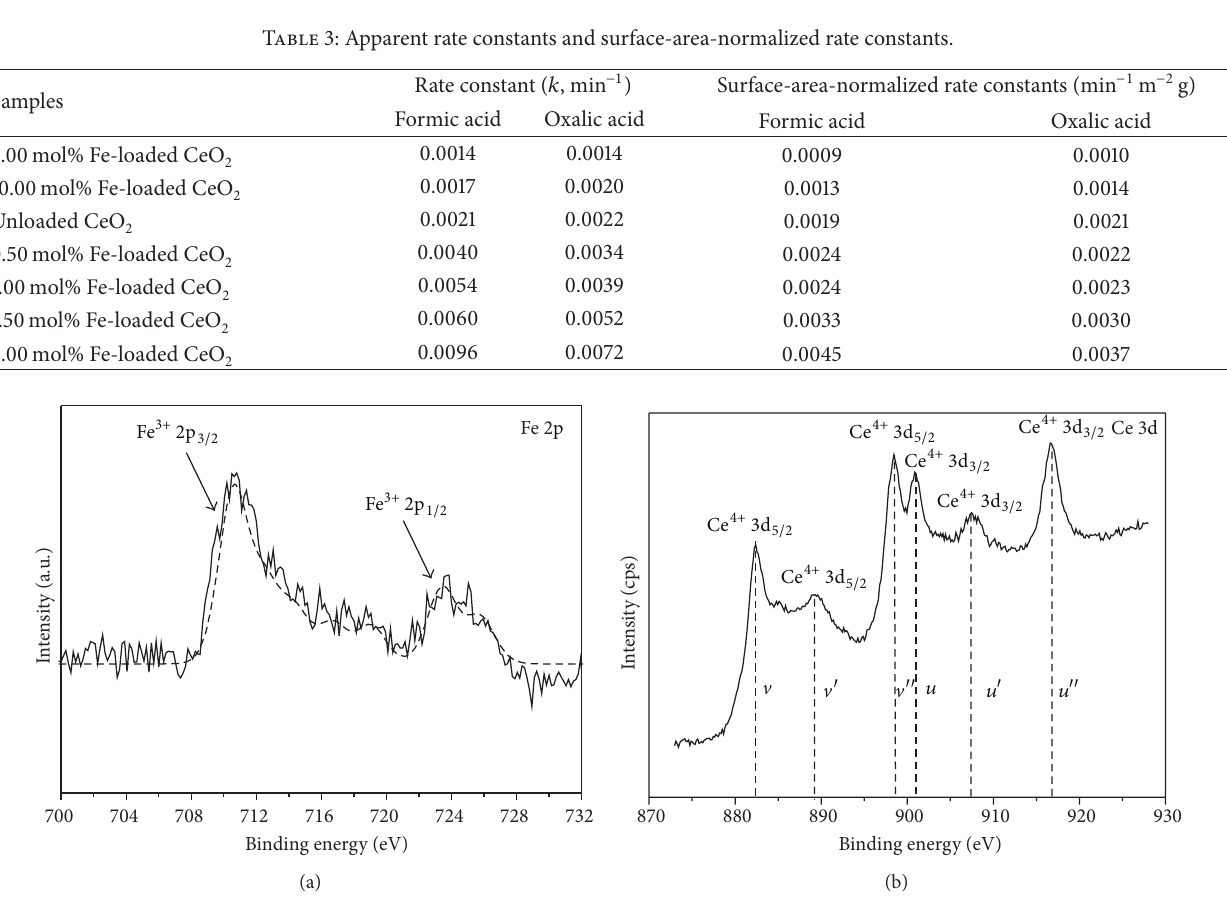
Figure 8: The XPS spectra of Fe-loaded CeO 2 nanoparticles: (a) Fe 2p and (b) Ce